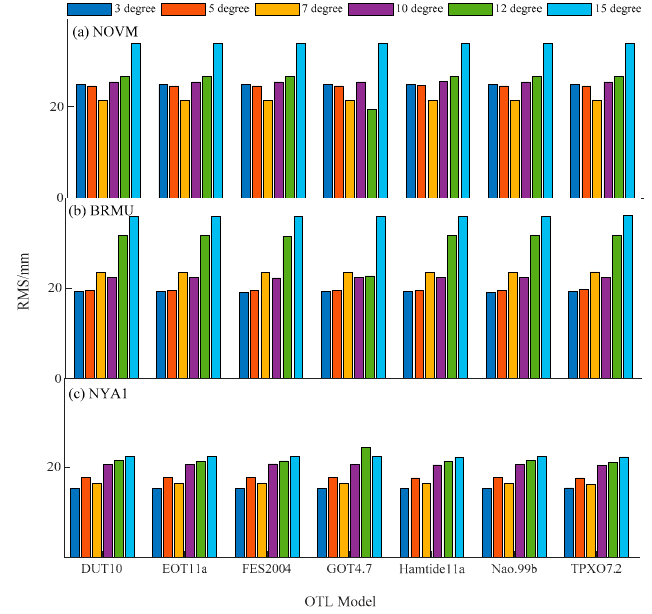
Figure 12. The RMS differences between the GNSS-derived ZTD and radiosonde stations with six cut-off angles and different OTL models at the ( a ) NOVM station, ( b ) BRMU station, and ( c ) NYA1 station. Figure 13 shows the RMS differences between the GNSS-derived ZTD and the radiosonde- derived ZTD at 10 stations with six cutoff angles using the FES2004 model. The results indicated that the adoption of a smaller cutoff elevation, e.g., 3° or 7°, significantly reduces the difference between the ZTDs determined with GNSS versus radiosonde, compared with using a 15° cutoff elevation. Compared to the radiosonde-derived ZTD, the RMS error of the GNSS-derived ZTD was approximately 25–35 mm at a cutoff elevation of 15°, and only 15–25 mm with a cutoff elevation of 3° at all stations. At the inland station, POVE, the RMS error was reduced from 25 mm to 10 mm when the cutoff elevation changed from 15° to 7°. Figure 13. The RMS differences between the GNSS-derived ZTD and the radiosonde-derived ZTD at 10 stations with six cutoff elevations using the FES2004 model at ( a ) inland, ( b ) island, and ( c ) coastal areas.